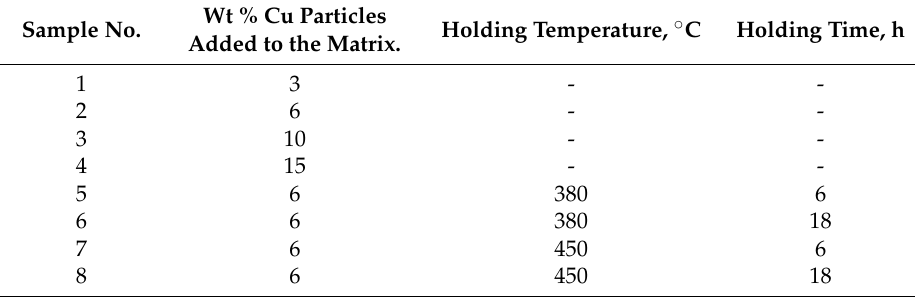
Table 1. The experimental conditions employed in the present study. Wt % Cu Particles Sample No. Holding Temperature, ˝ Added to the Matrix.